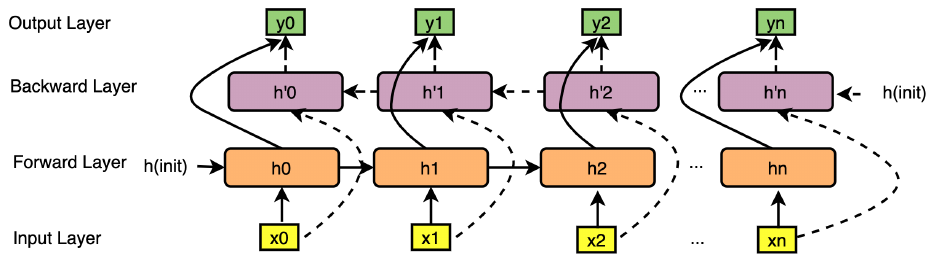
Figure 5. Bidirectional Gate Recurrent Units